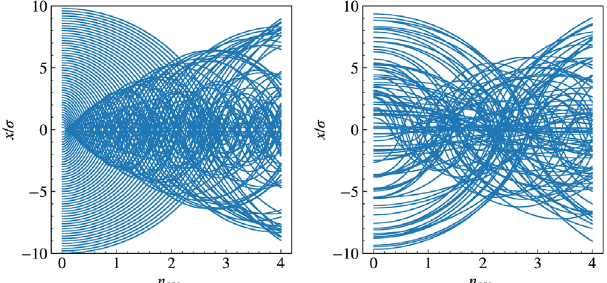
FIG. 20. Simulated pinch of the neutral MDM molecules in a cold gas, i.e., T=T (cid:3) μ ¼ 0 . The particles are distributed either uniformly only in the x plane (left) or randomly distributed (right) in a circular beam pipe of radius R p ¼ 10 σ .